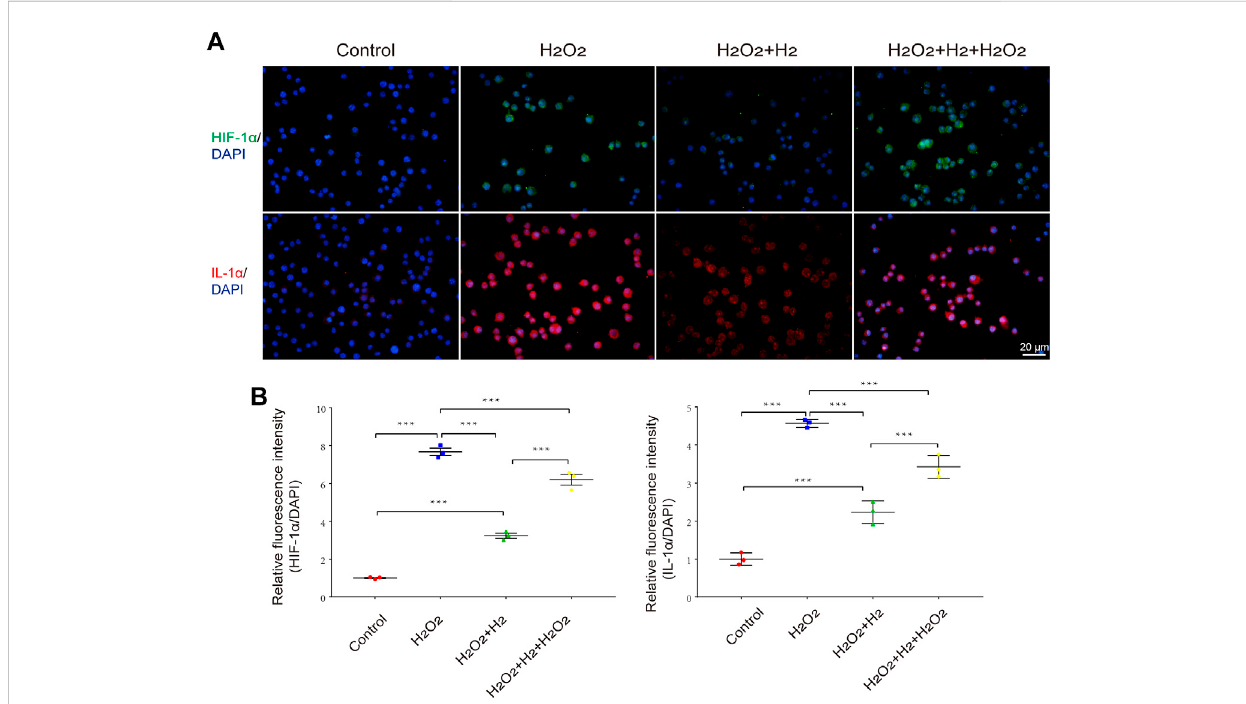
FIGURE 5 Effects of hydrogen on H 2 O 2 -induced HIF-1 α and IL-1 α expression in RAW264.7 cells. (A) Representative images of HIF-1 α and IL-1 α activation in responseto31.26 μ